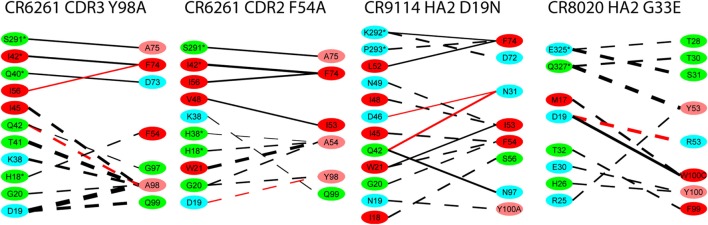
Interaction energy differences for selected substitutions. Layout and coloring are the same as for Figure 2, but here the thickness of the line represents the difference in interaction energy relative to the wild type. Dotted lines represent weaker interaction (reduced absolute ΔΔG) and solid lines represent stronger interaction. Only differences with an absolute value ≥1.0 kcal/mol are shown.